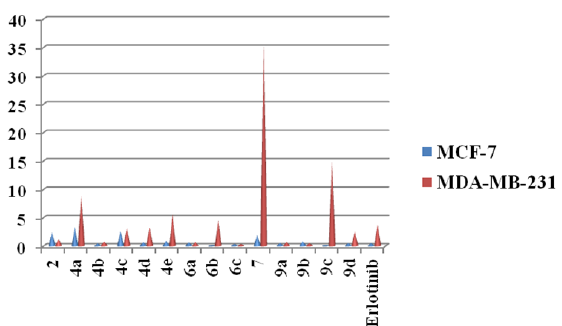
Figure 2. Pyramid graph for cytotoxic data of the target compounds and control drug against two cancer cell lines.